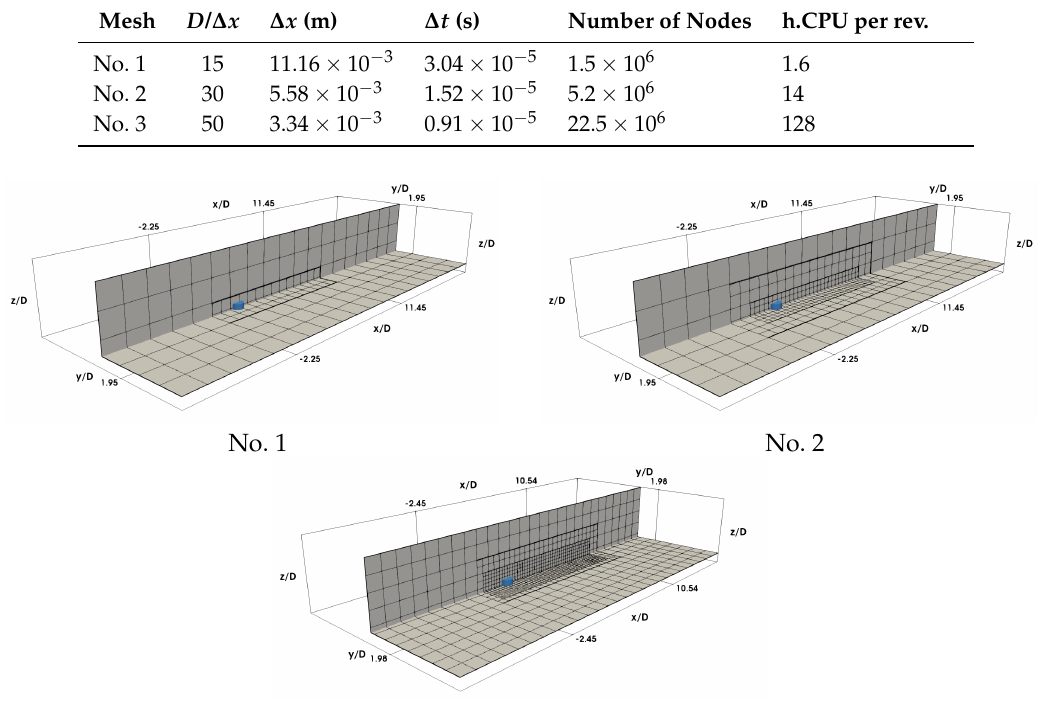
Figure 4. Meshes used for the ALM-LBM mesh sensitivity study. Meshes are represented in cubes of 14 × 14 × 14 nodes. Turbine is represented with the blue cylinder. Plane xy is at turbine mid-height and plane xz is at canal mid-width.